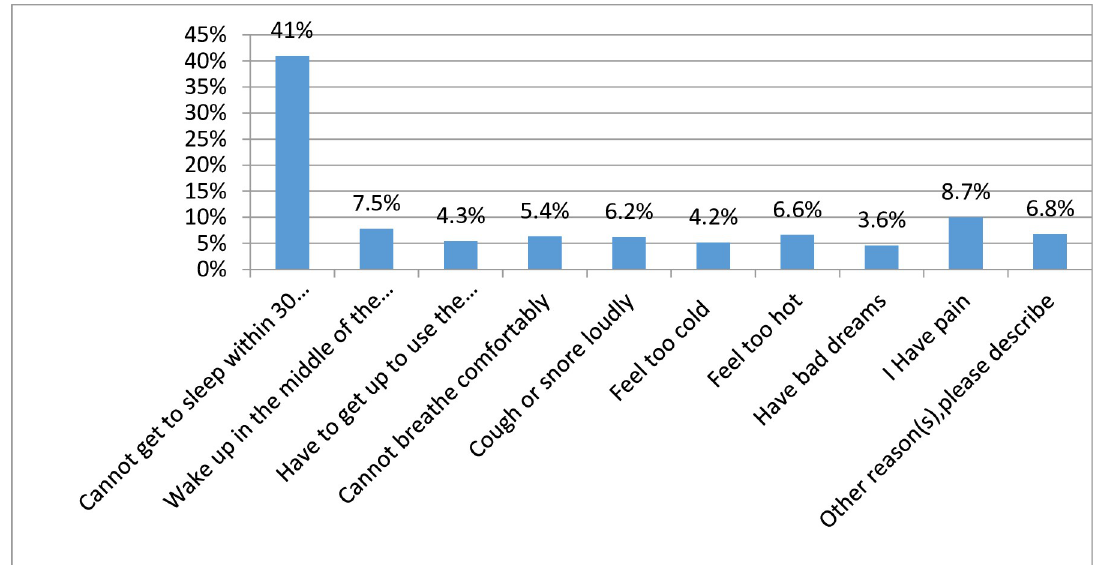
Fig 1. Reasons for difficulty sleeping in adult HTN patients at chronic follow-up care clinics in northwest Amhara regional state referral hospitals in Northwest Ethiopia, 2021 (n = 563).